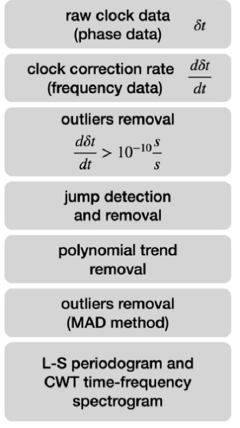
Figure 2. Clock data processing algorithm.